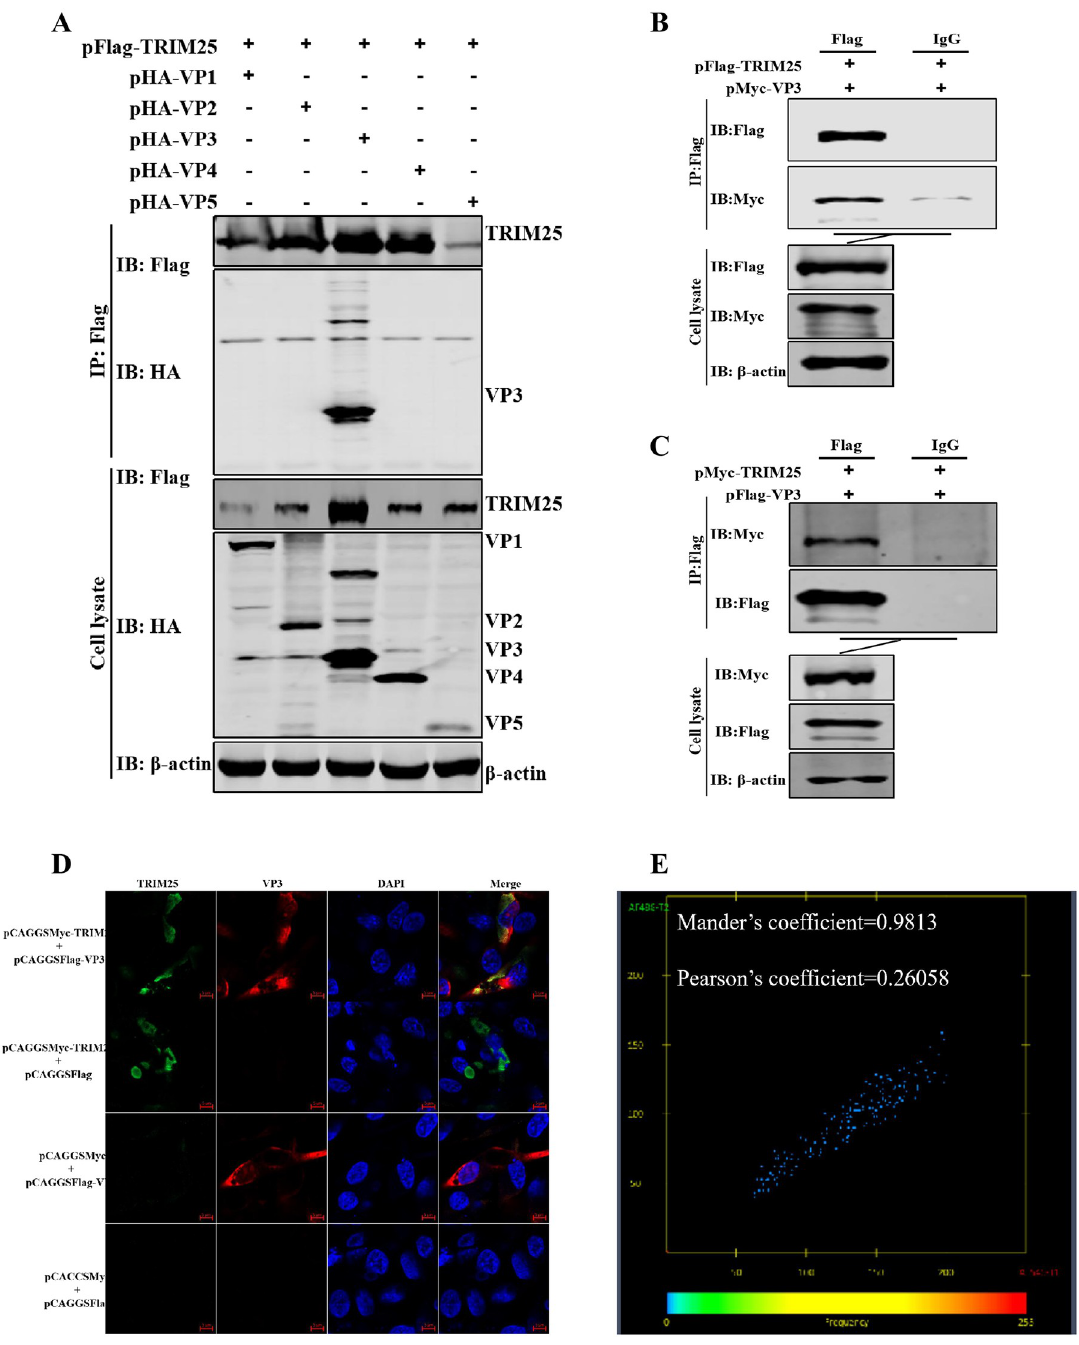
Fig 4. TRIM25 interacts with VP3. (A-C) Relationship between TRIM25 and VP3 was determined by Co-IP assays in DF-1 cells. (A) Lysates were incubated with anti-Flag mAb and tested using the indicated antibodies by Western blotting. Cells were co-transfected with pFlag-TRIM25 and pHA-VP1, pHA-VP2, pHA-VP3, pHA-VP4, or pHA-VP5 for 48 h, respectively. (B) Cells were harvested after co- transfection with pFlag-TRIM25 and pMyc-VP3 for 48 h. The lysates were incubated with 1 μ g anti-Flag mAb or IgG produced in mice. (C) Cells were co-transfected with pFlag-VP3 and pMyc-TRIM25 at 48 h p.i. The lysates were incubated with 1 μ g anti-Flag mAb or IgG produced in mice. (D) Confocal assays were used to assess the colocalization between TRIM25 and VP3. DF-1 cells were co-transfected with pFlag-TRIM25 and pHA-VP3 for 36 h. Cells were incubated with anti-Flag mAb produced in mice and anti-HA mAb produced in rabbits and the interaction between TRIM25 and VP3 was determined by confocal assay. (E) Colocalization analysis with Mander’s coefficient (0.9813) and Pearson’s coefficient (0.26058) on the confocal image.